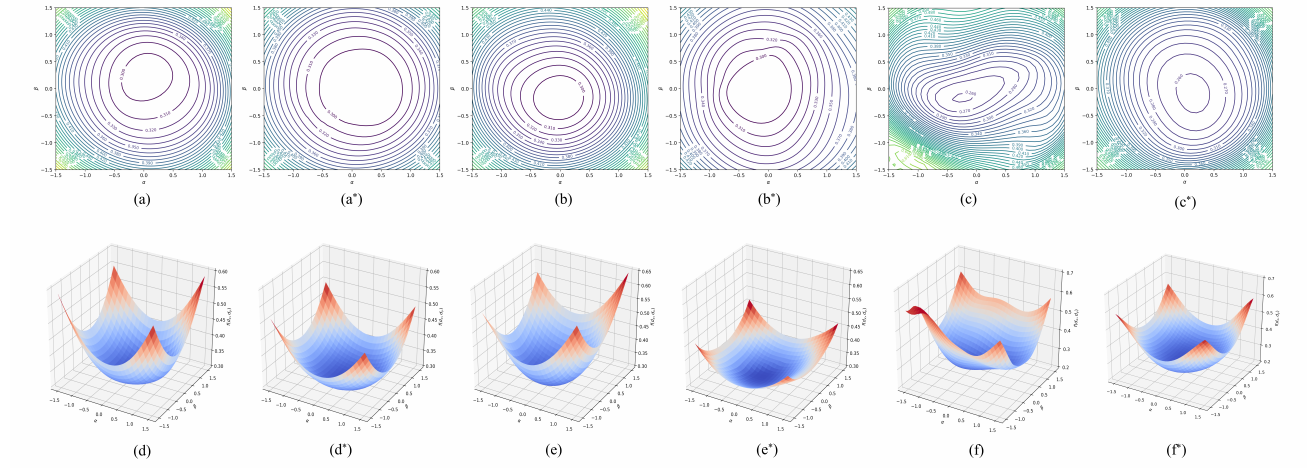
Figure 6. 2D and 3D visualization of the minima of the loss function selected by standard training ( a – f ) and hierarchical adversarial training ( a* – f* ) on the PHEME 17 ( a , a* , d , d* ), PHEME 18 ( b , b* , e , e* ) and WEIBO ( c , c* , f , f* )